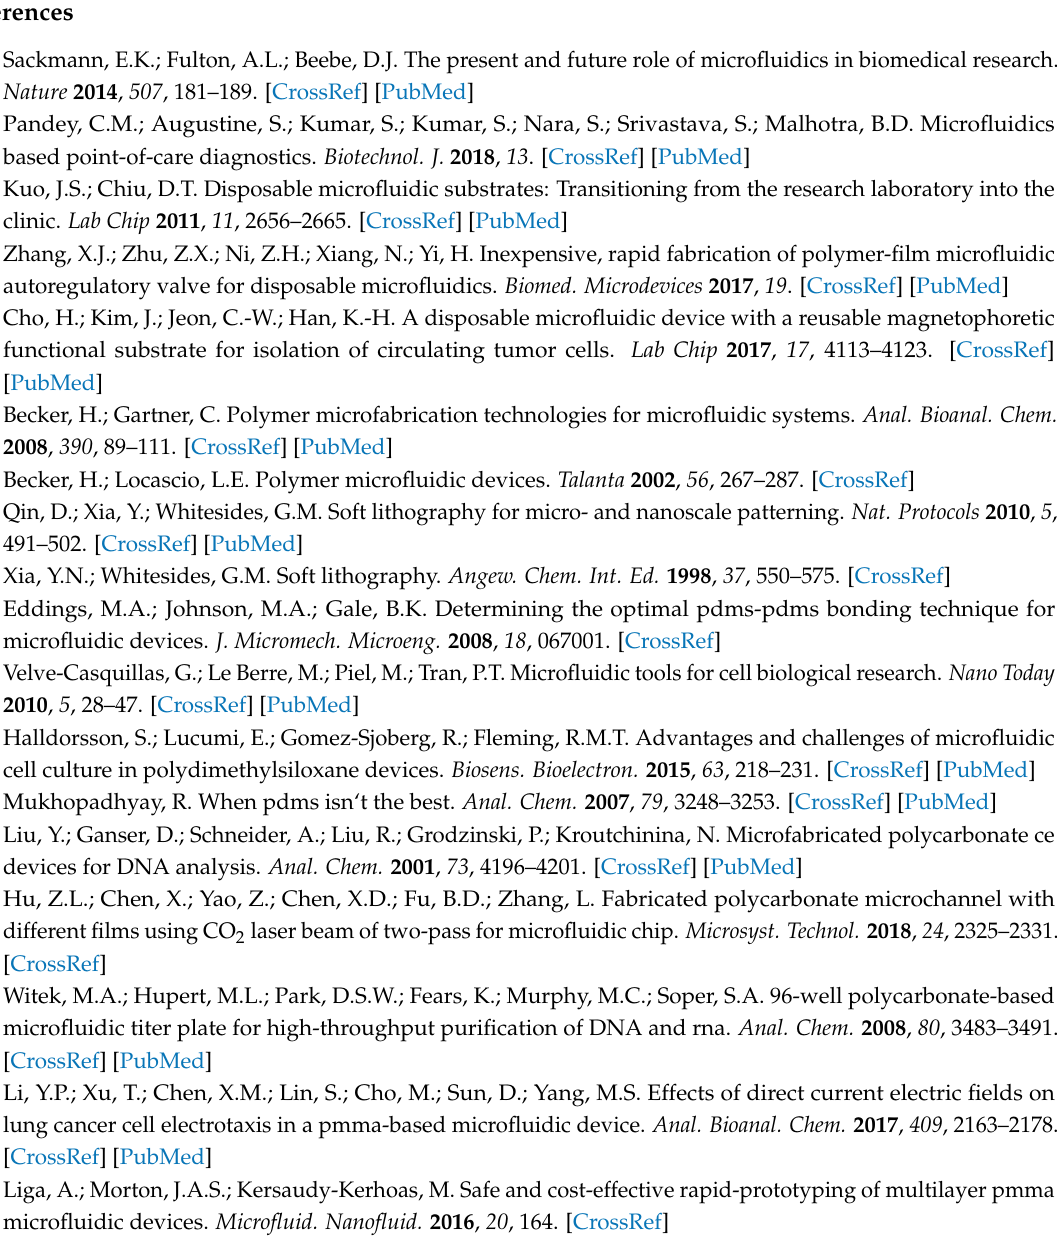
Table S1: Comparison of general thermal and mechanical properties of COC, COP, and CBC; and Table S2: Comparison of chemical resistance properties of COC, COP, and CBC. Figure S1: The Fourier Transform Infrared Spectroscopy (FTIR) analysis of CBC. Figure S2: Auto-fluorescence measurement of CBC-1 comparing to polystyrene. Figure S3. Experiment setup for thermal fusion and UV/Ozone